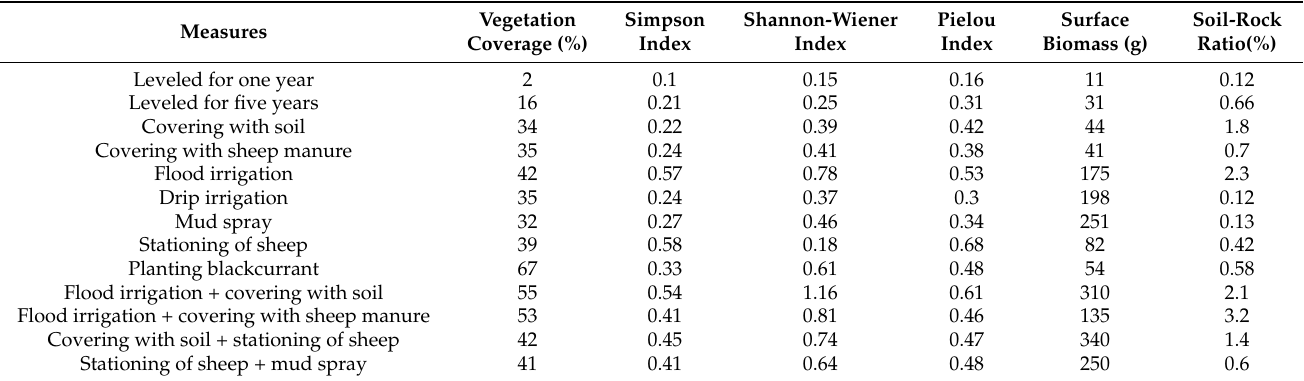
Table 1. Recovery efficiency of different measures.